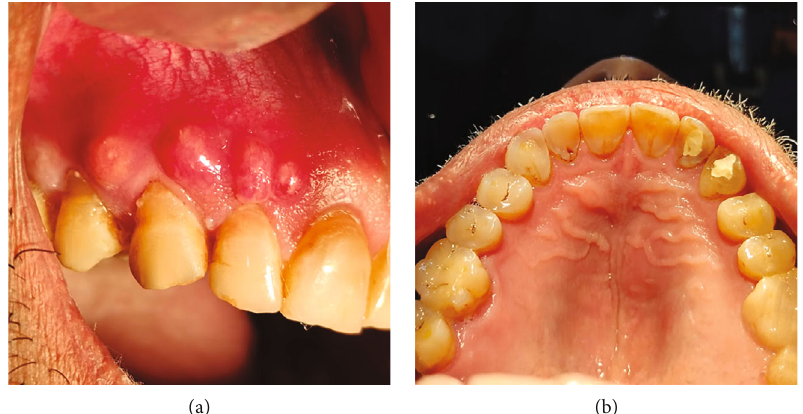
Figure 9: Clinical photograph of case 3 showing multiple swellings apical to the maxillary right lateral incisor and maxillary canine, with palatal swelling indicated with an arrow.